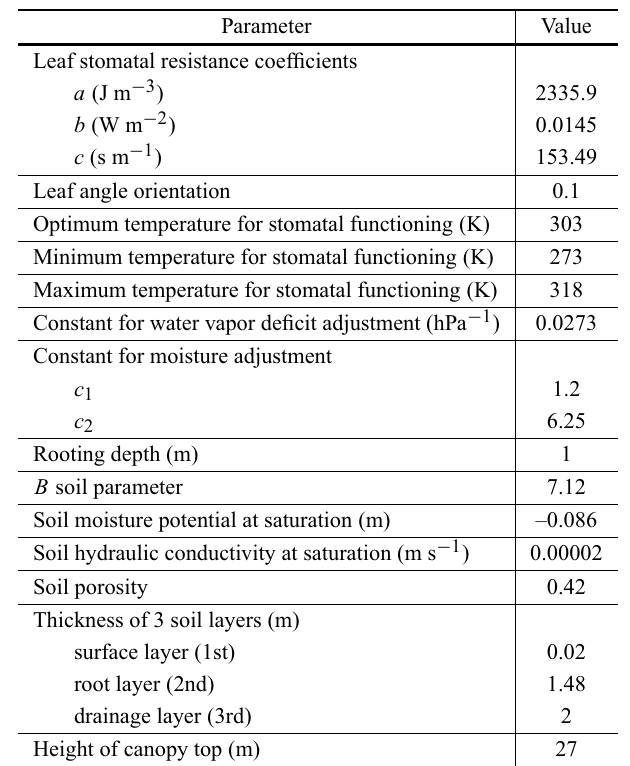
Time invariant SSiB parameters for the new tropical seasonal forest biome type (see text for detailed